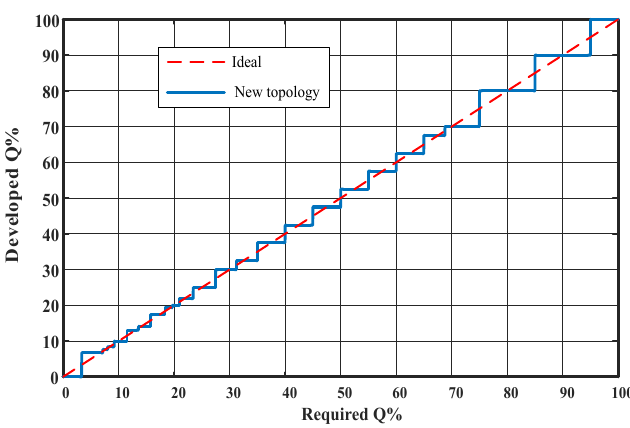
Fig. 3. The optimal characteristics of the new TSR and TSC